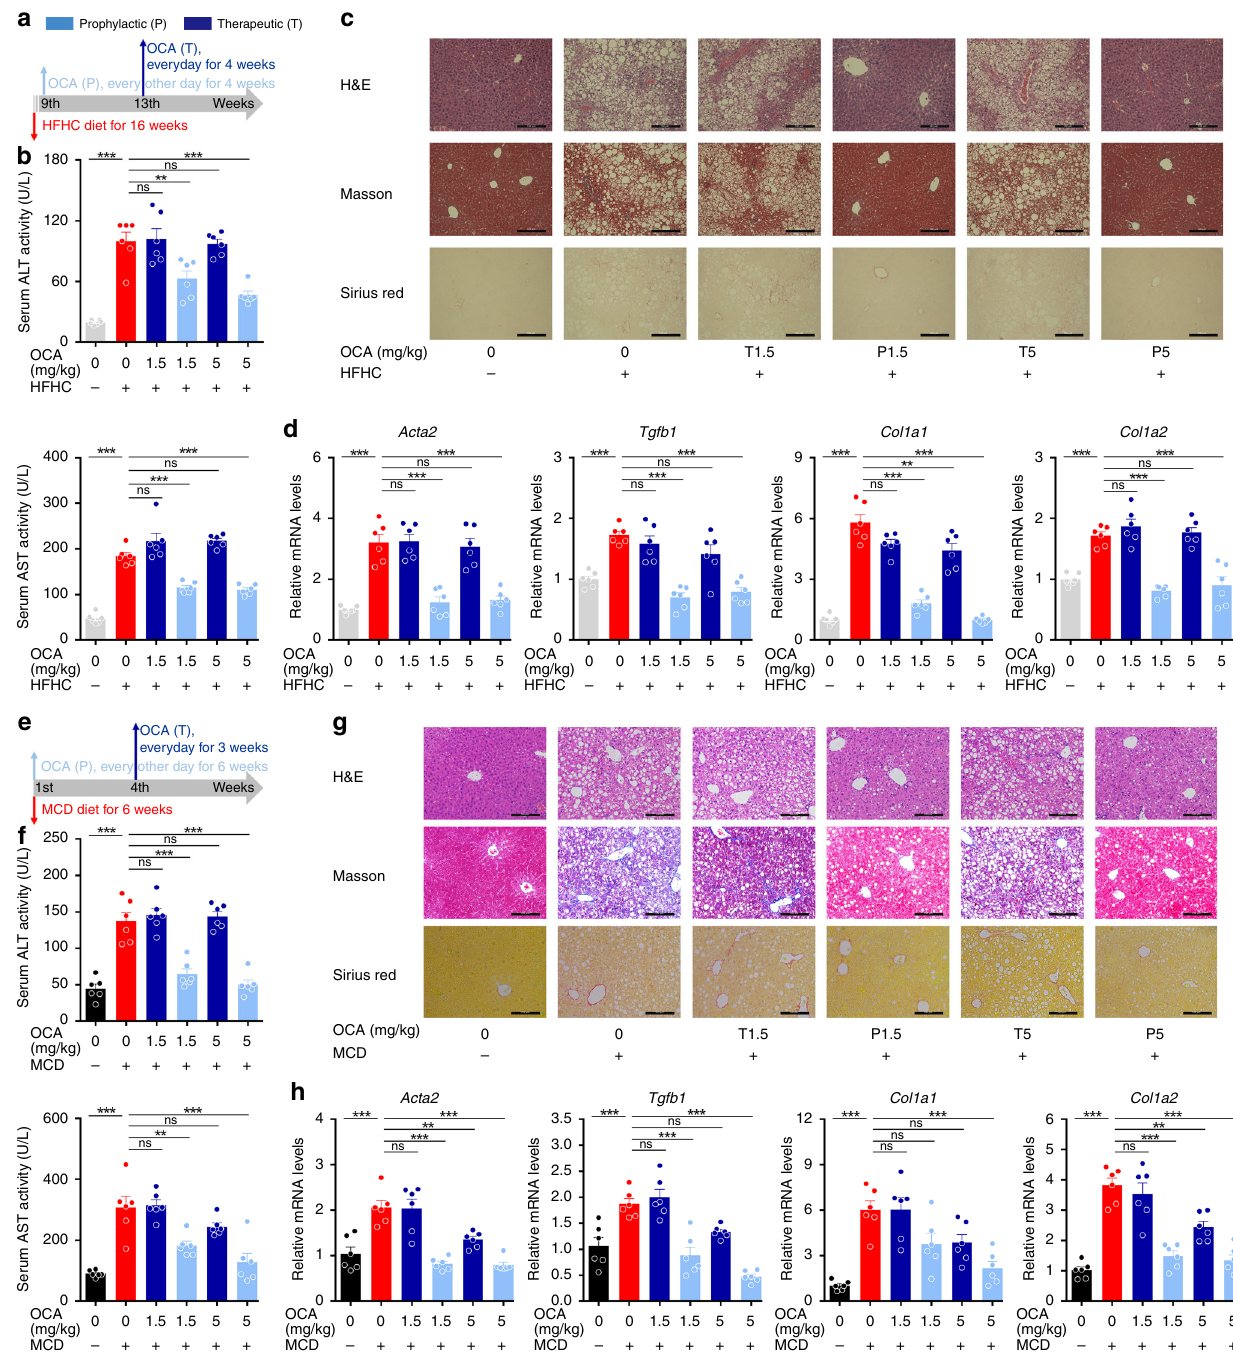
Fig. 2 Prophylactic but not therapeutic OCA administration cures NASH-induced fi brosis. The effects of prophylactic and therapeutic administration of OCA were evaluated in NASH-induced fi brosis models caused by HFHC a – d and MCD e – h diet. a and e Mouse experiment procedure schemes. b and f Serum ALT and AST levels. c and g H&E, Masson and Sirius red staining of liver sections. Data are representative of n = 6 biological independent samples. Scale bar, 100 μ m. d and h Levels of Acta2 , Tgfb1 , Col1a1 , and Col1a2 mRNAs in liver. n = 6 biologically independent samples within these experiments. Results are mean ± SEM, * P < 0.05, ** P < 0.01, *** P < 0.001, and ns, statistically not signi fi cant, as assessed with